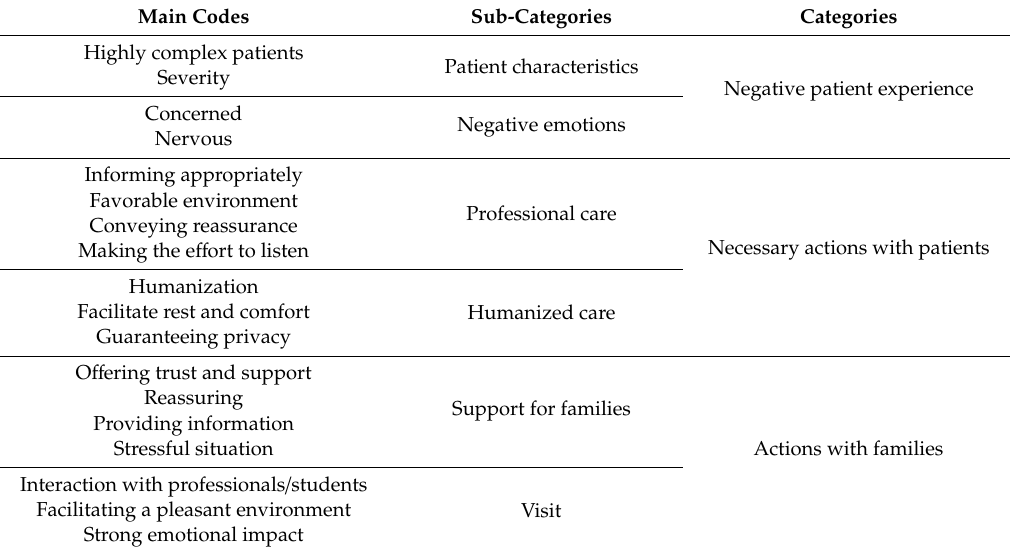
Table 4. Main categories, sub-categories and codes about the theme “how to improve care for critically ill patients and support their